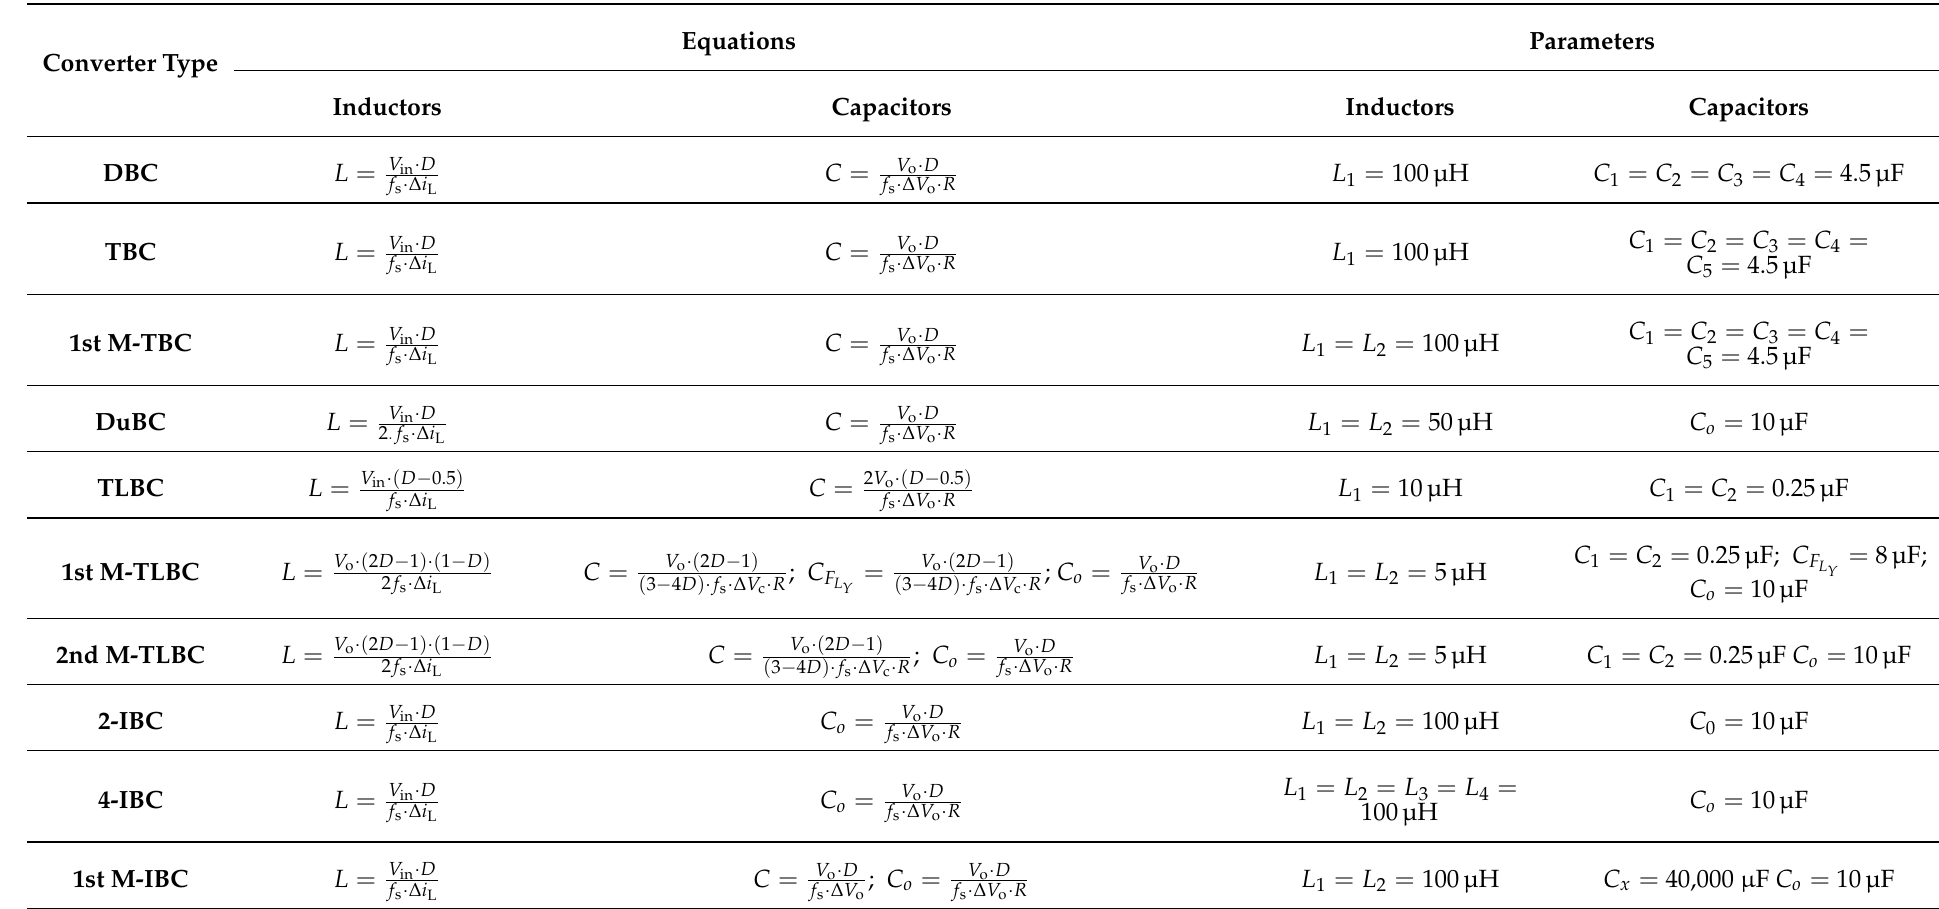
Table 1. Analytical equations for component parameter